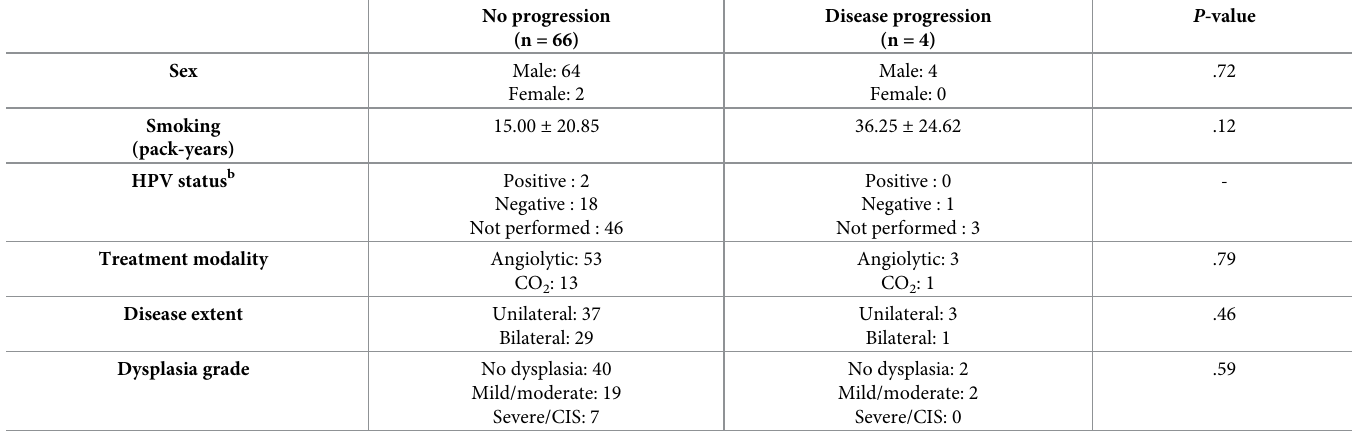
Table 3. Analysis of clinicopathologic findings related to malignant transformation a .